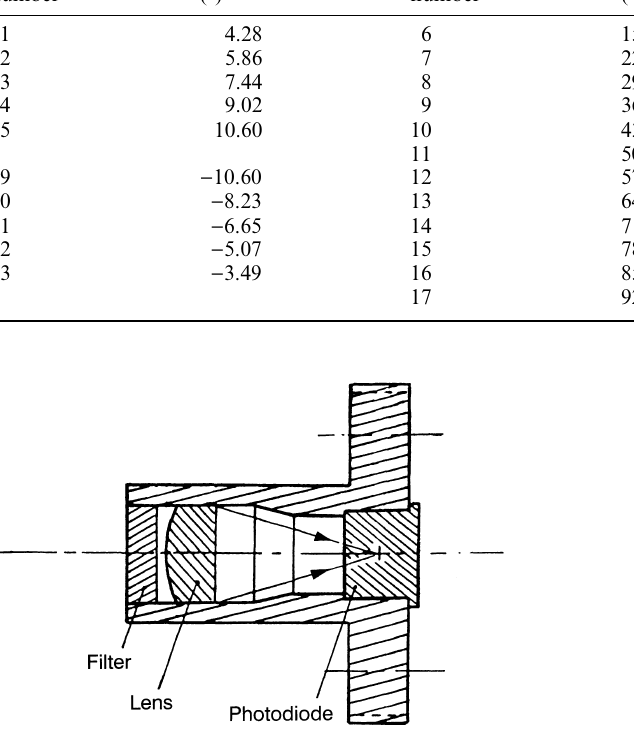
Fig. 5. Schematic diagram of the optical detector equipped with lenses